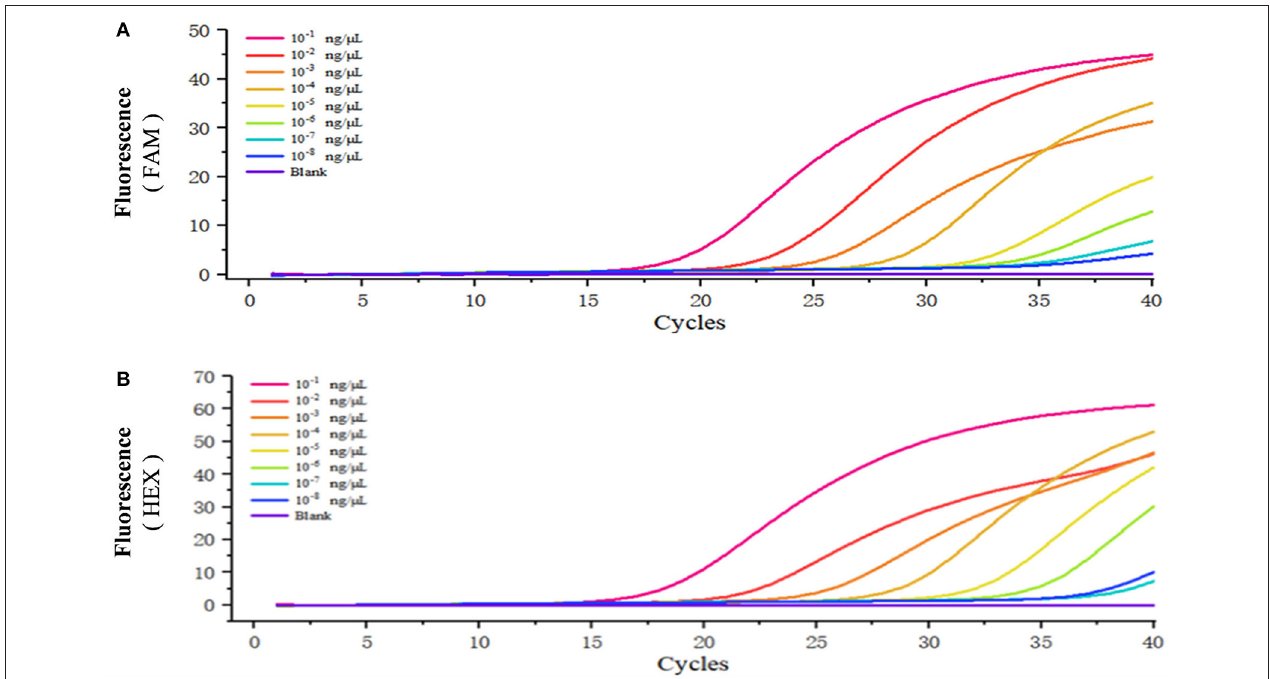
FIGURE 4 | Sensitivity of the duplex real-time fluorescence quantitative PCR method. The standard positive plasmid was diluted into different concentrations (ng/ µ L): 1 × 10 − 1 , 1 × 10 − 2 , 1 × 10 − 3 , 1 × 10 − 4 , 1 × 10 − 5 , 1 × 10 − 6 , 1 × 10 − 7 , and 1 × 10 − 8 , respectively, and sterile ddH 2 O was considered as blank control. (A) results of the standard positive plasmid of B. caballi . (B) results of the standard positive plasmid of T. equi .